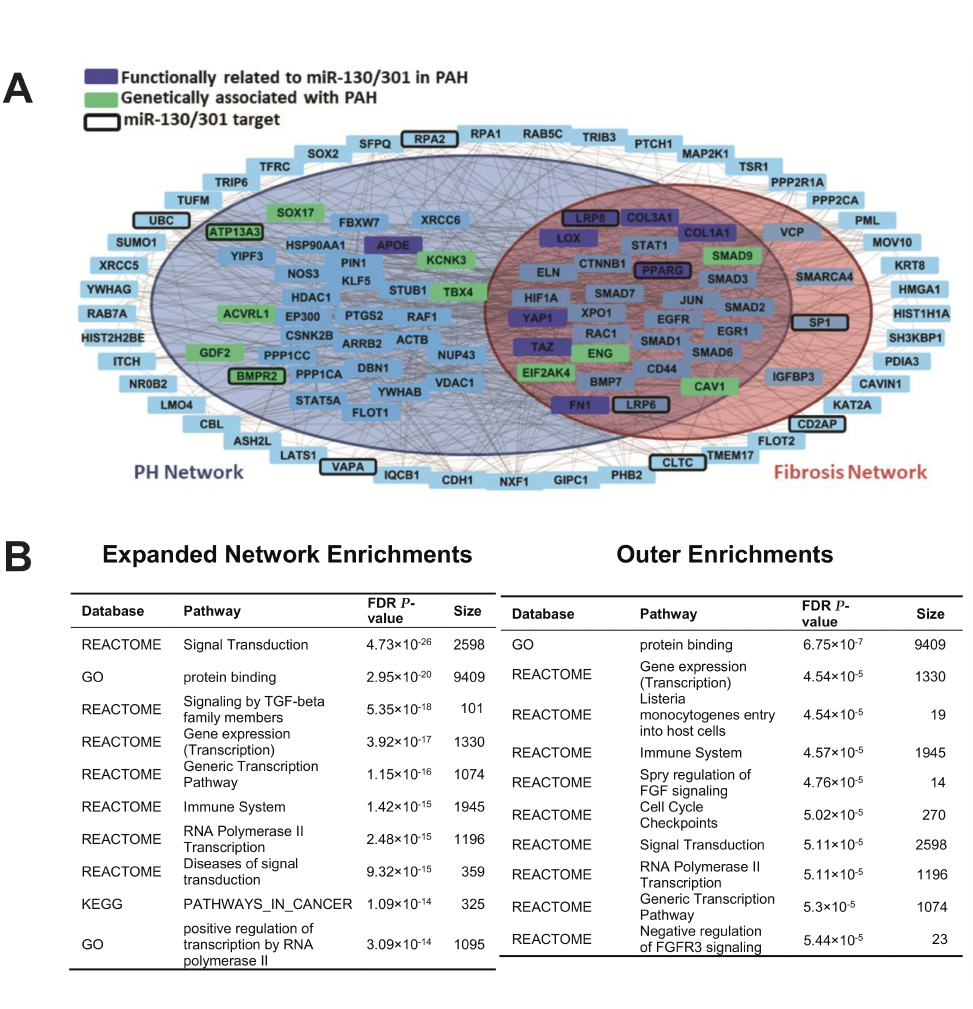
Figure 5. A network bioinformatics approach predicts the complex and overlapping relationships among factors genetically associated with PAH with known miR-130/301 target genes, PH genes, and fibrosis genes. ( A ) Network model. Gray lines indicate an interaction between two genes. Genes in dark blue are functionally related to miR-130/301 members in PAH, and genes in green are associated with heritable PAH. Genes with a thickened border are predicted targets of miR-130/301 in TargetScan [21]. Genes found in the larger blue circle are common to the PH Network, and those found in the orange circle are common to the Fibrosis Network. ( B ) In the left table, top-ranked pathways via gene set enrichment analysis (GSEA) are listed of genes found in the PH and Fibrosis Networks interacting with known miR-130/301 target genes and factors genetically associated with PAH (e.g., genes located in the inner colored circles of ( A )). In the right table, top-ranked pathways are listed of genes interacting with miR-130/301 target genes and factors associated with heritable PAH found outside the PH/Fibrosis Networks (e.g., genes located outside the colored circles of ( A